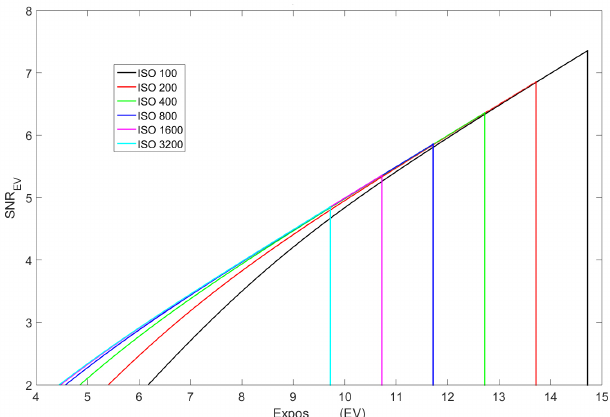
Figure 6. SNR curves vs. Exposure to photographic SNR